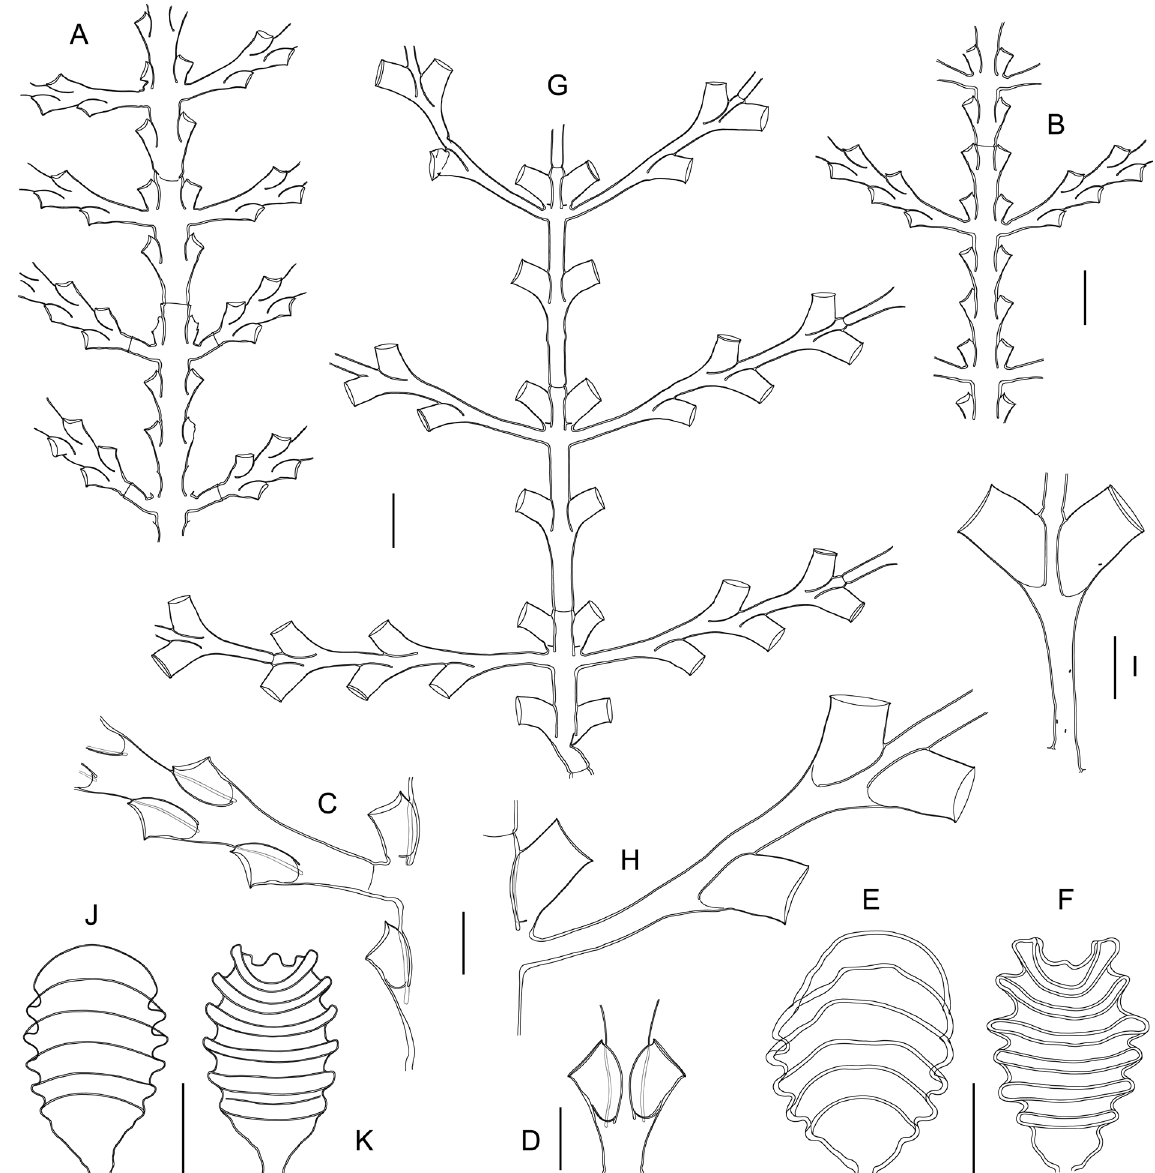
Fig. 8. A–F . Synthecium hians Millard, 1957, distal portions of two stems (A–B), fragment of stem with insertion of cladium (C), all from sample MNHN-IK-2015-486; pair of hydrothecae from distal part of cladium (D) from sample MNHN-IK-2015-494; gonotheca in frontal (E) and lateral (F) aspects, from sample MNHN-IK-2015-486. — G–K . Synthecium rectangulatum Galea, sp. nov., distal portion of a stem (G), fragment of stem with insertion of cladium (H), pair of hydrothecae from distal part of cladium (I), gonotheca in frontal (J) and lateral (K) aspects, all from sample MNHN-IK-2015-485. Scale bars: A–B, G = 1 mm; C–F, H–K = 500